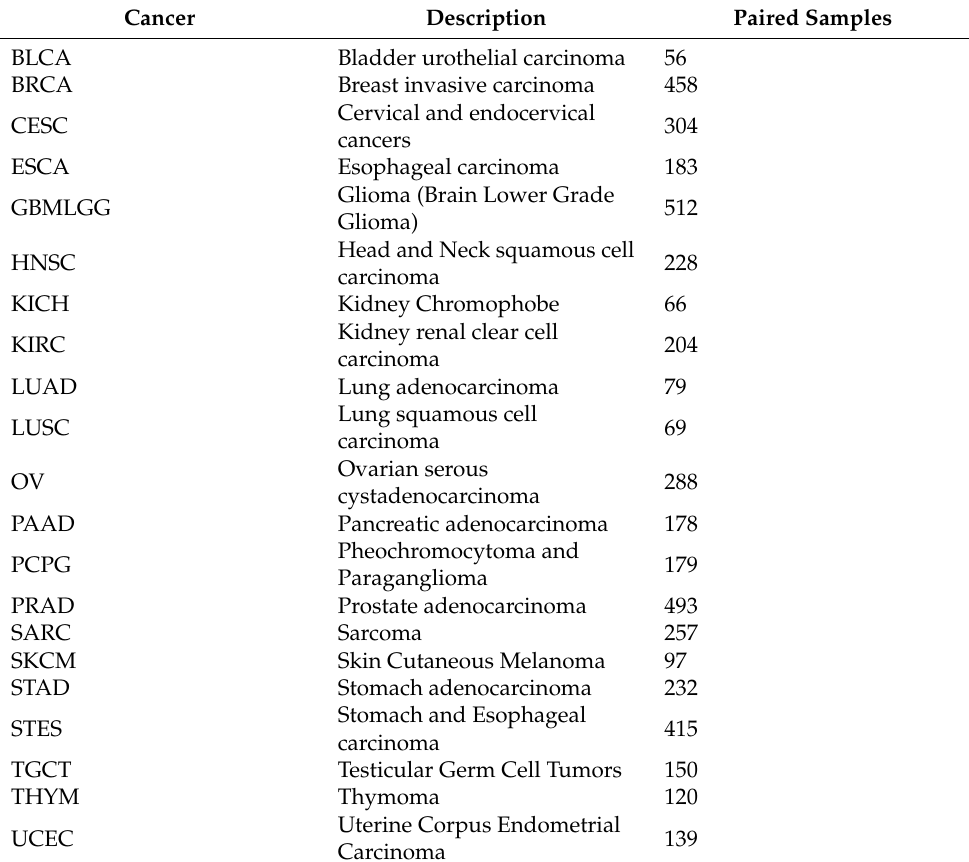
Table 1. Summary of miRNA and mRNA sequencing datasets from 21 different